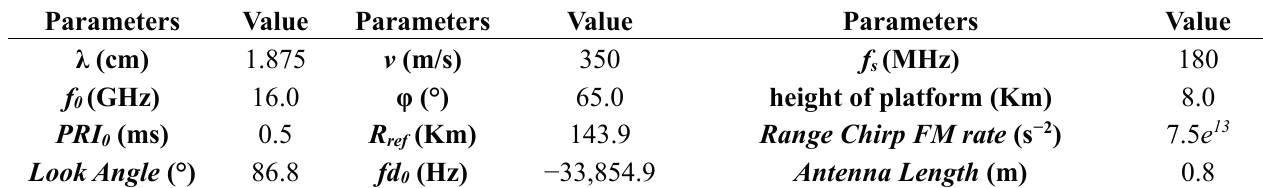
Table 1. Main simulation parameters.